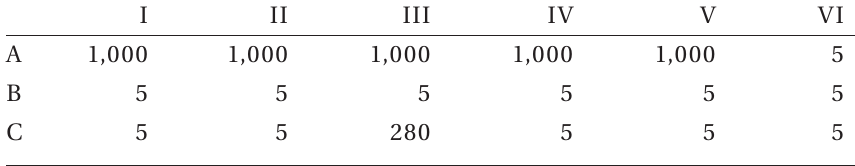
Table 2.3 Upper limit sufficientarianism (with no one below the